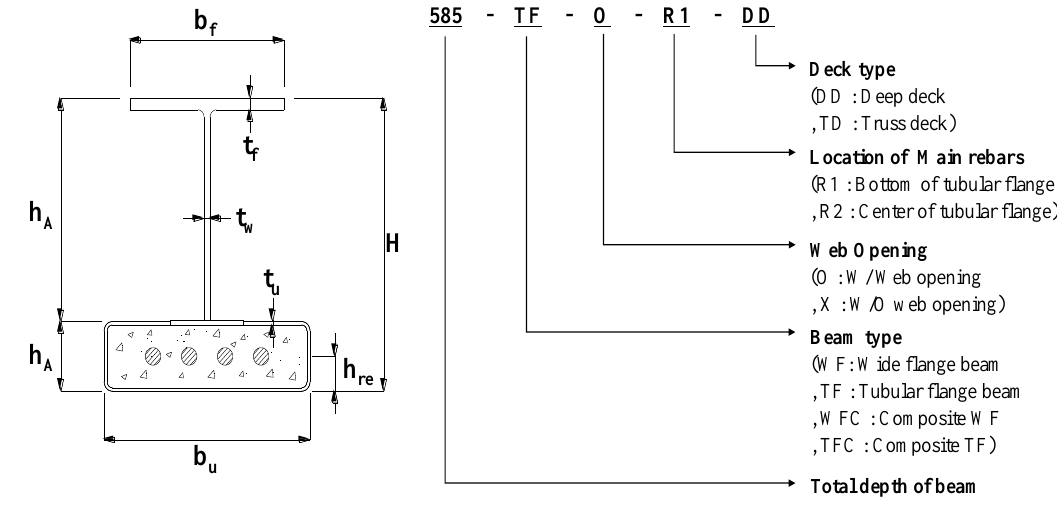
Figure 3. Specimen identification. Table 1. Details of test specimens.